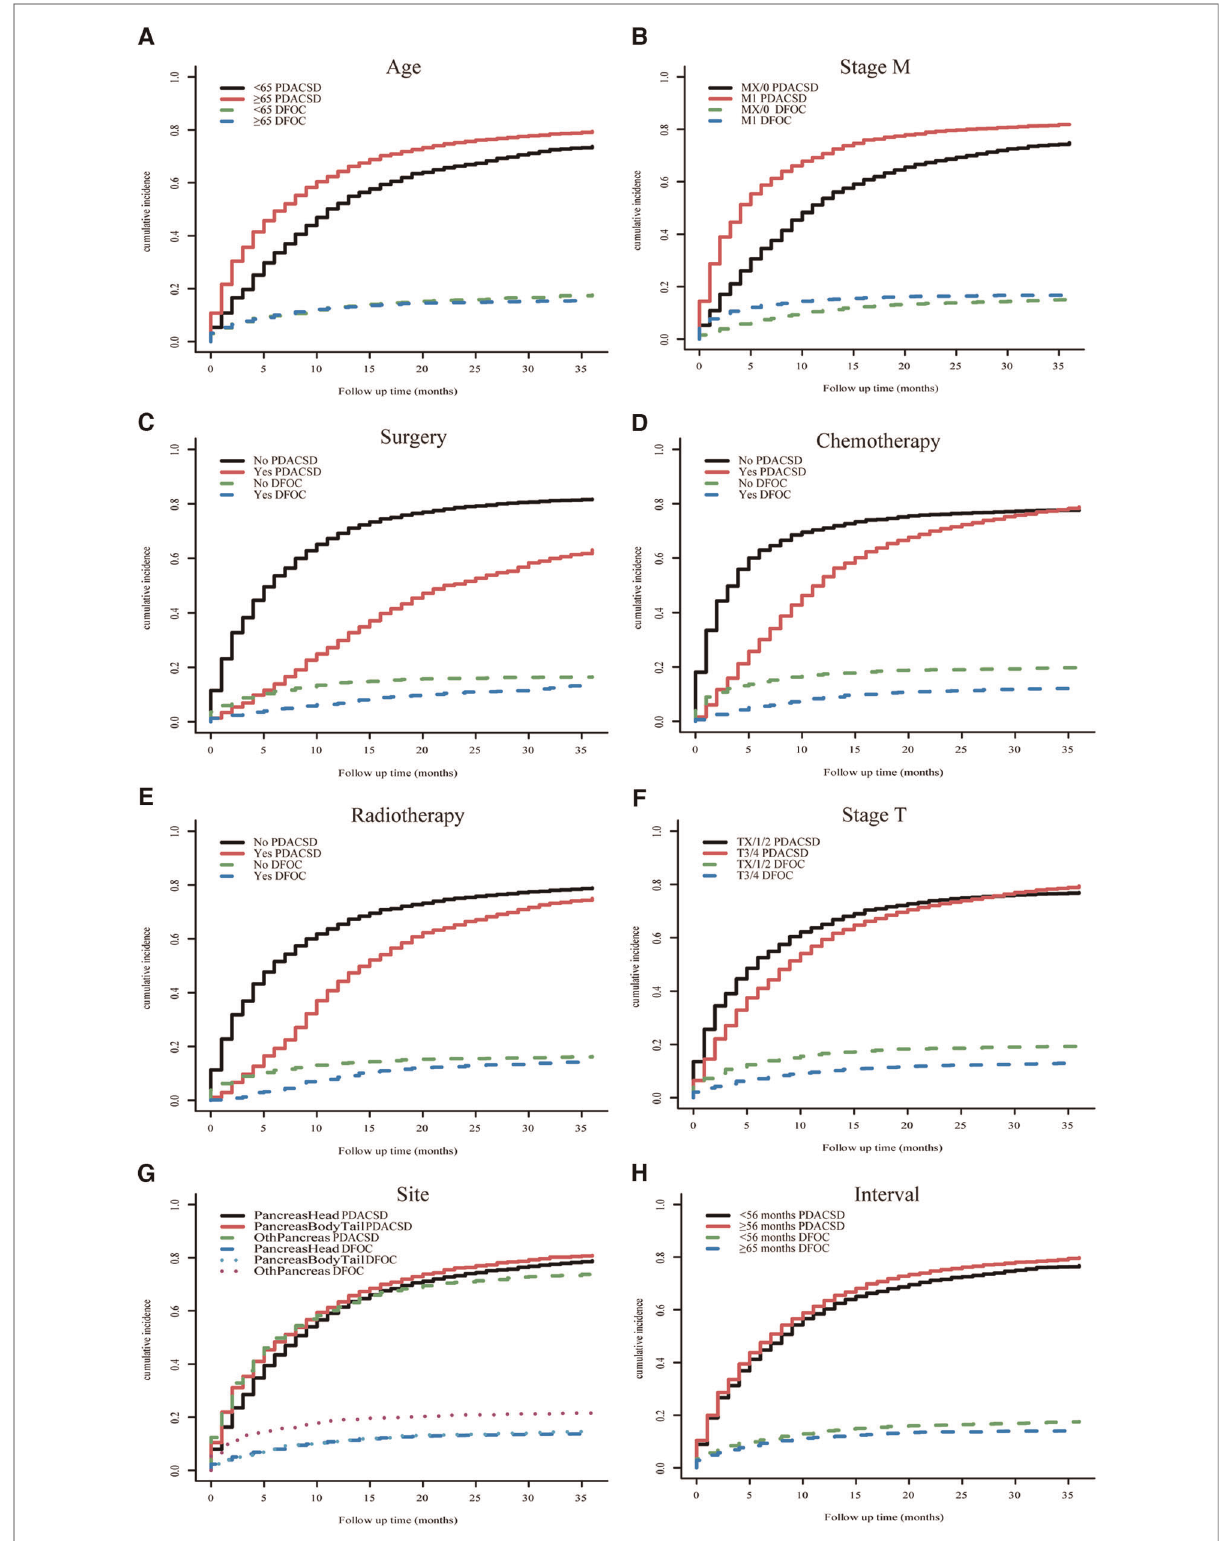
FIGURE 5 Univariate Fine – Gray test was used to analyze the cumulative incidence of pancreatic ductal adenocarcinoma-speci fi c death and death from other causes. Age ( A ), M stage ( B ), surgery ( C ), chemotherapy ( D ), radiotherapy ( E ), T stage ( F ), location ( G ), and time interval ( H ).